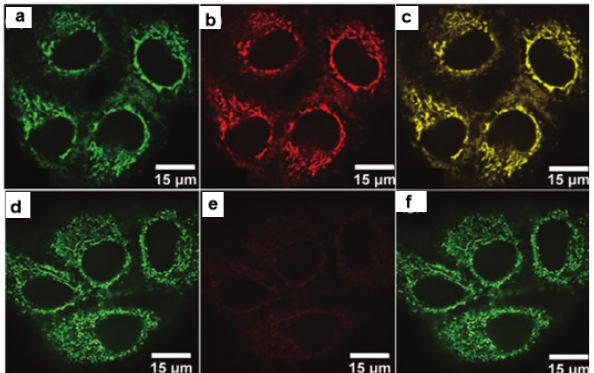
4 of 38 Figure 3. Confocal fluorescence images of HeLa cells and human dental pulp cells stained with BODIPY 2 . ( a , b ) Bright field image, ( c , d ) fluorescence images under a red channel (650 nm). Adapted from [20]. A year later, Jiang and co-workers reported two novel fluorescent BODIPY dyes, 3 and 4 , for mitochondrial imaging (Scheme 3a) [21]. Lipophilic BODIPY 3 was afforded through a Knoevenagel condensation of 4-dimethylaminobenzaldehyde with the corre- sponding BODIPY. Water-soluble BODIPY 4 was afforded through methylation of 3 with methyl iodide (Scheme 3b). MTT experiments showed that the 3 and 4 have good biocom-